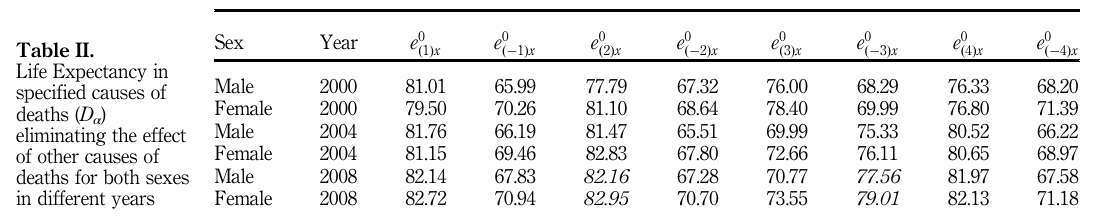
Table I. Life expectancy for male and female starting at zero age